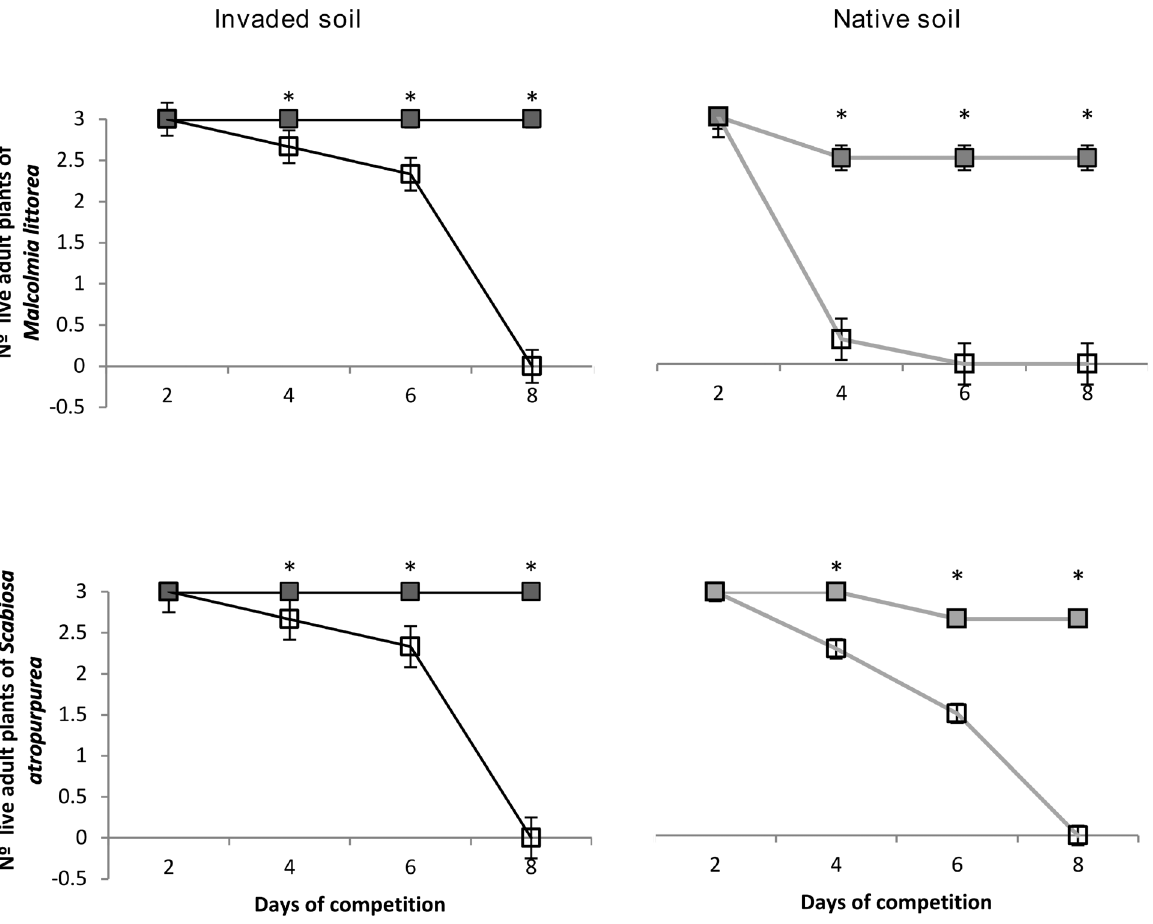
Figure 2. Survival of the native plants Malcolmialittorea and Scabiosaatropurpurea in pure adult cultures (3 adult native plants) and mixed adult/ramets cultures (3 adult native plants against 1 ramet of C.edulis ) on invaded and native soil. *: indicate differences ( P # 0.05) between monocultures (filled squares) and mixed (empty squares).